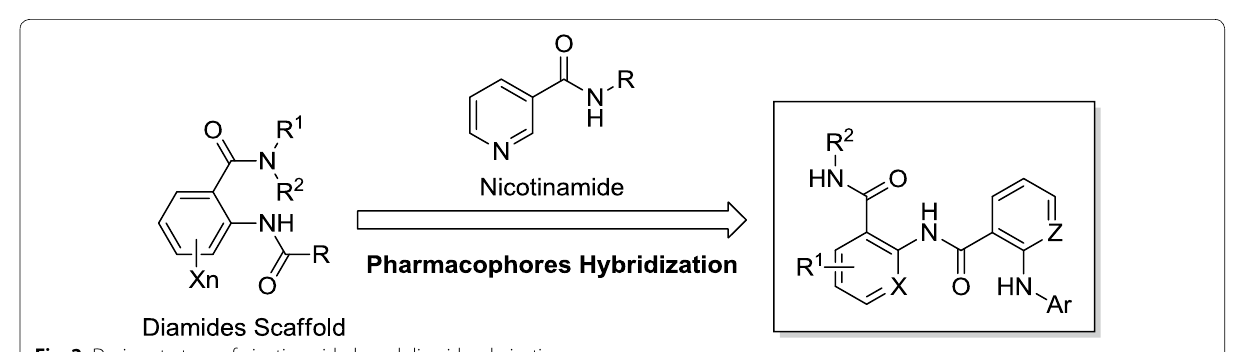
Fig. 2 Design strategy of nicotinamide-based diamides derivatives